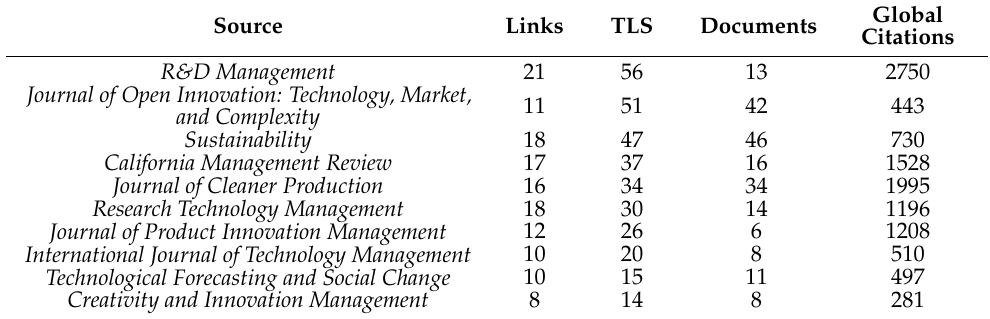
Table A5. Structural bibliometric indicators for the top ten sources included in the citation network (ranked by TLS).